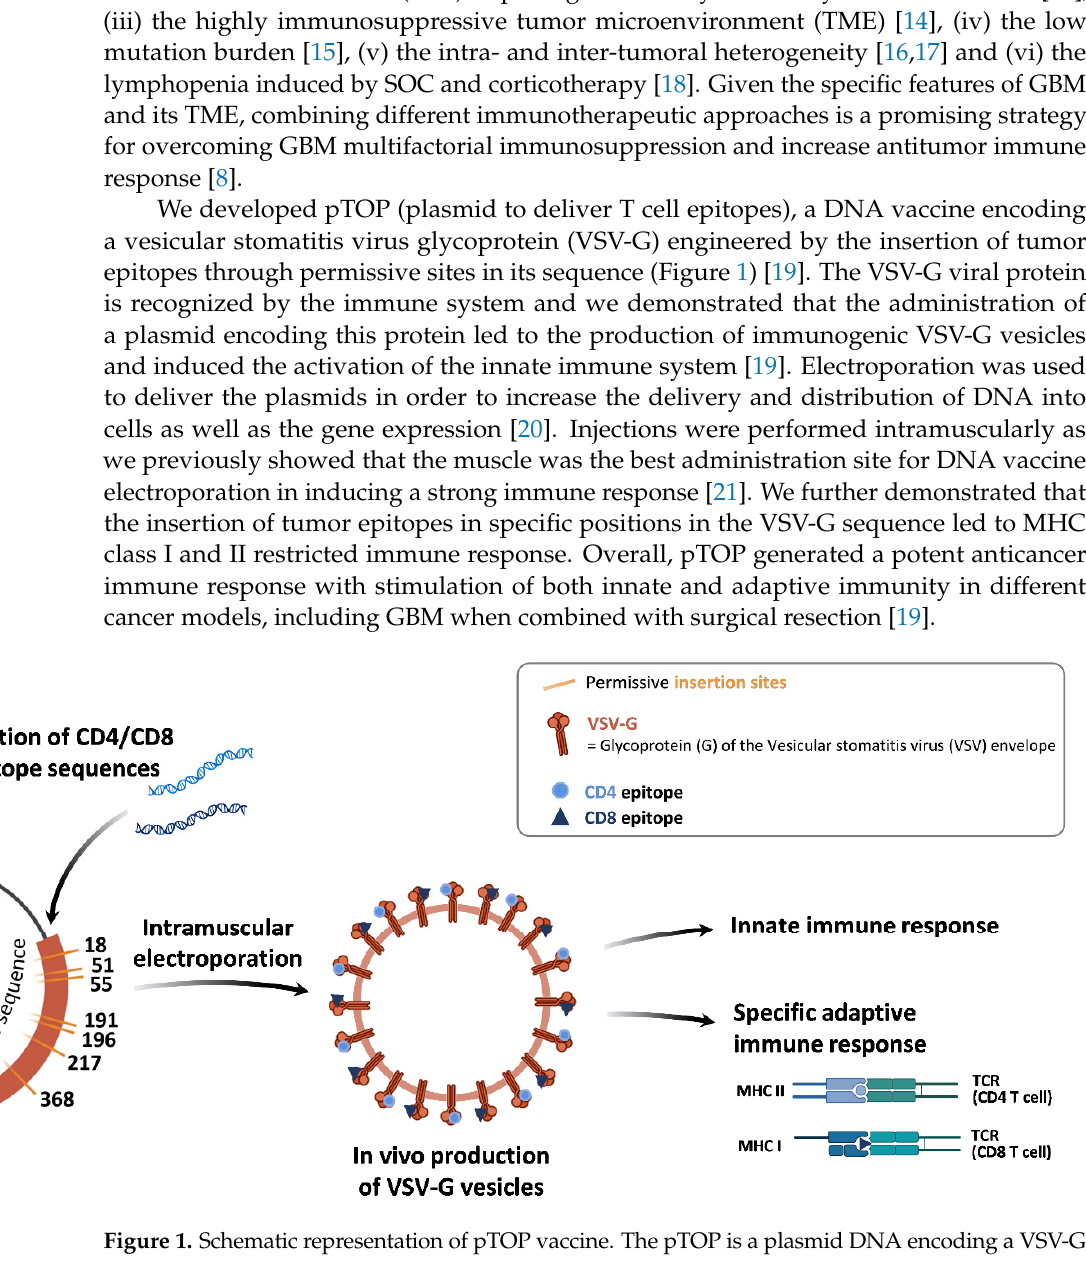
Figure 1. Schematic representation of pTOP vaccine. The pTOP is a plasmid DNA encoding a VSV- G sequence modified by the insertion of tumor epitope sequences in permissive sites. After admin- istration of pTOP, cells will produce VSV-G vesicles incorporating CD4 and/or CD8 epitopes. These immunogenic vesicles will activate both the innate immunity and the adaptive immunity by presen- tation of the epitopes through the MHC class I or II molecules to the CD8 or CD4 T cells. (TCR = T cell